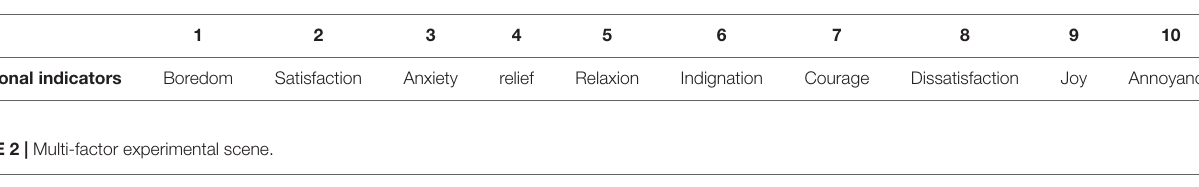
TABLE 1 | User emotion record before the experiment.